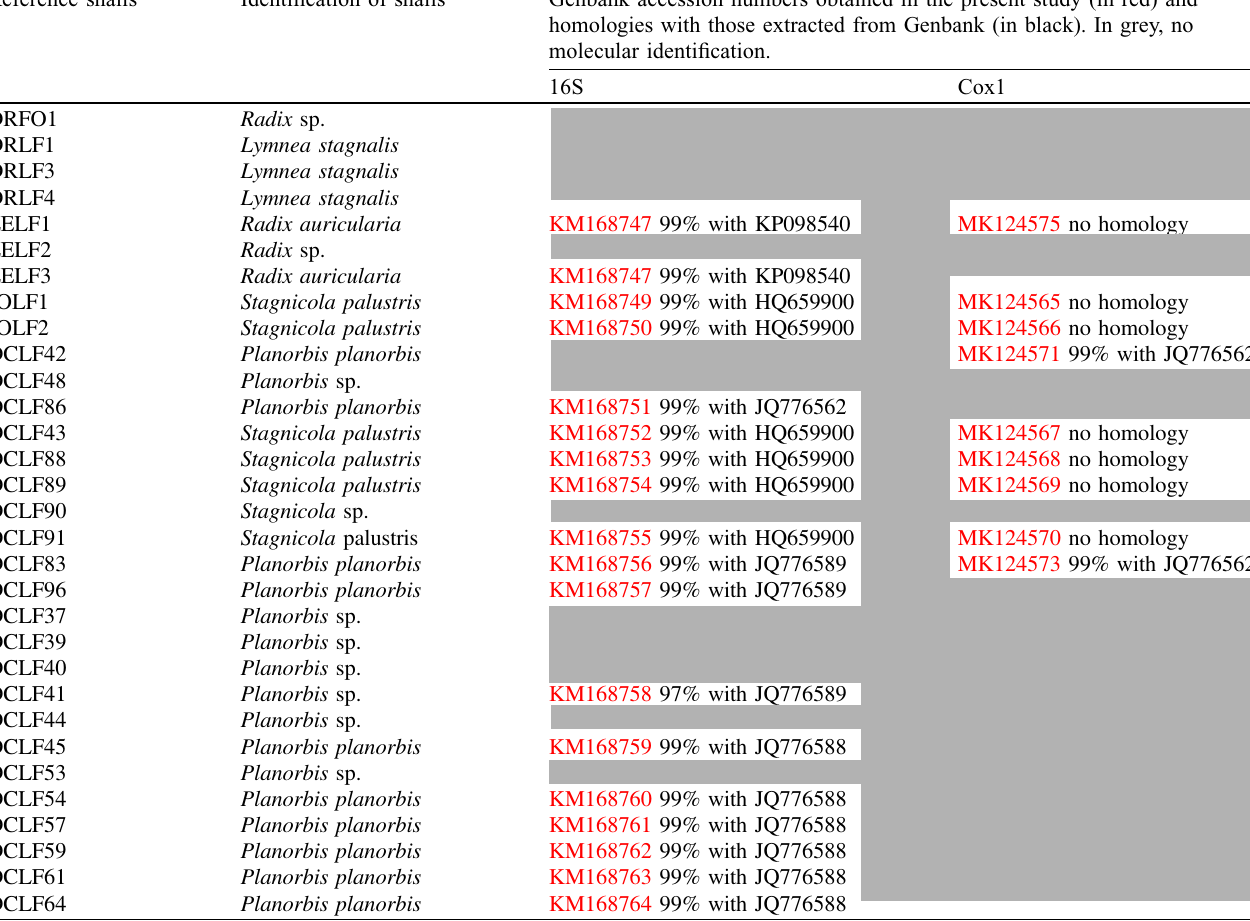
Table 3. Molecular identi fi cation of snail hosts. Reference snails Identification of snails Genbank accession numbers obtained in the present study (in red) and homologies with those extracted from Genbank (in black). In grey, no molecular identification. 16S Cox1